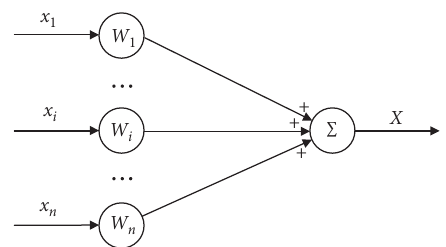
Figure 3: Multisource information